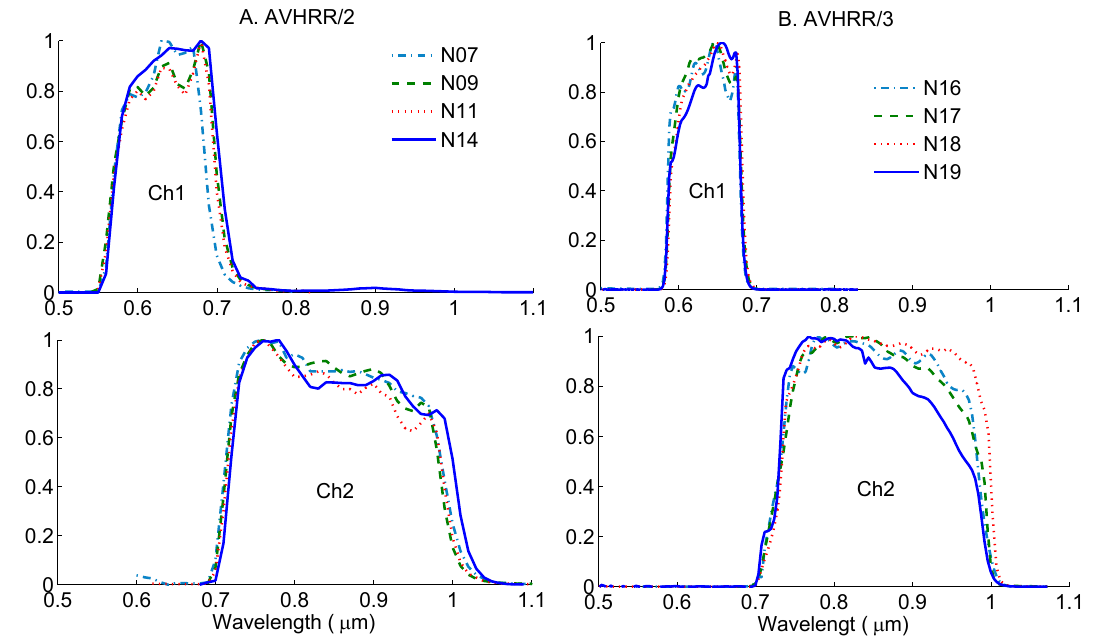
Figure A1. The spectral response functions (SRF) of the VNIR channels for the ( A ) NOAA-7/9/11/14 AVHRR/2 and ( B ) NOAA-16/17/18/19 AVHRR/3 instruments are consistent among themselves but are slightly different from each other. In particular, the integrated spectral response function for the visible channel in the AVHRR/2 is about 0.11 μm compared to the AVHRR/3 integrated spectral response function of 0.08 μm bandwidth. The integrated spectral response functions for channel 2 for AVHRR/2 and AVHRR/3 are very